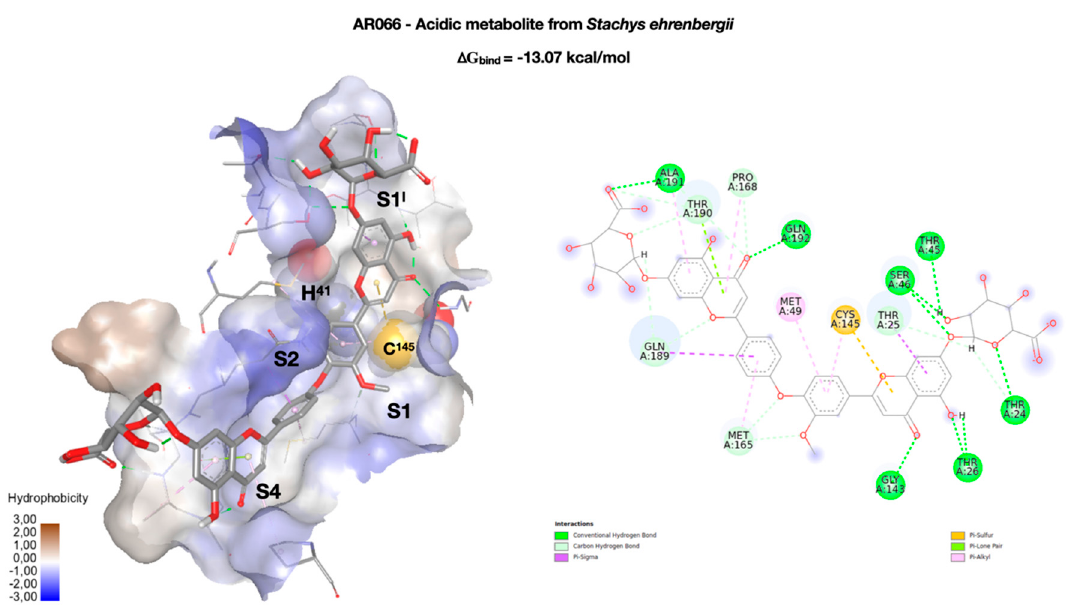
Figure 5. Best docking pose of an acidic metabolite isolated from the aerial parts of Stachys ehrenbergii (AR066). On the left, the conformation of AR066 (in stick) inside the enzymatic binding site, represented as the solvent accessible surface (SAS), and colored according to the hydrophobicity of the residues, rendered in wireframe. The two key residues of the catalytic dyad (H 41 and C 145 ) are rendered in CPK. The four binding pockets (S1 I , S1, S2, and S4) occupied by the molecule are highlighted. On the right, a two-dimensional representation of the molecular interactions between the ligand and the enzyme. The colors used refer to the different interactions, as indicated in the legend.